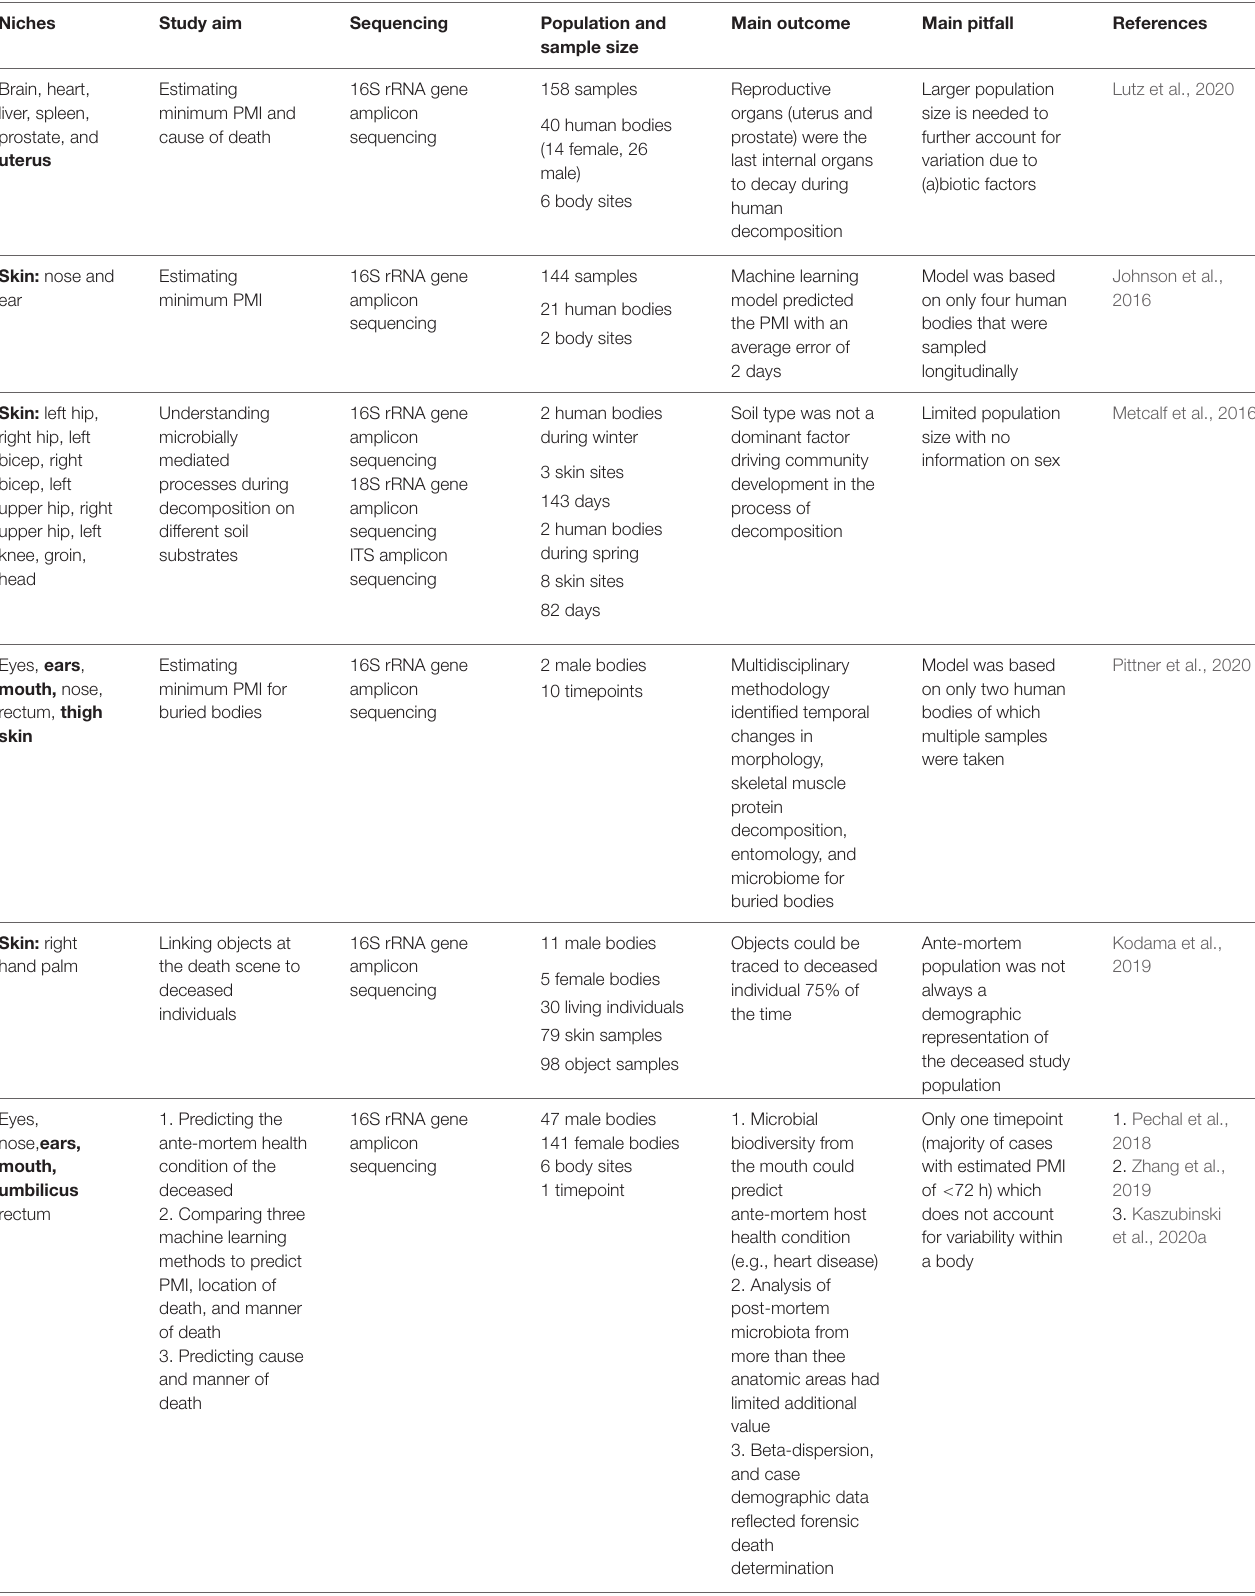
TABLE 1 | List of human post-mortem microbiome studies which include female reproductive tract, skin and/or oral cavity samples in the last 5 years.